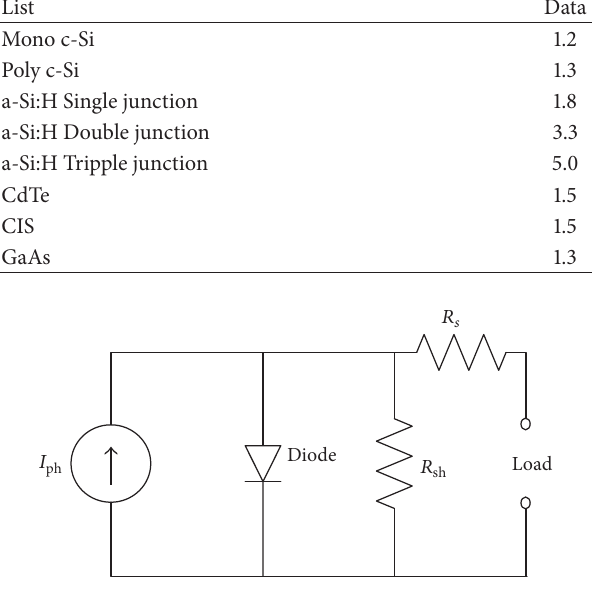
Figure 1: Photovoltaic equivalent